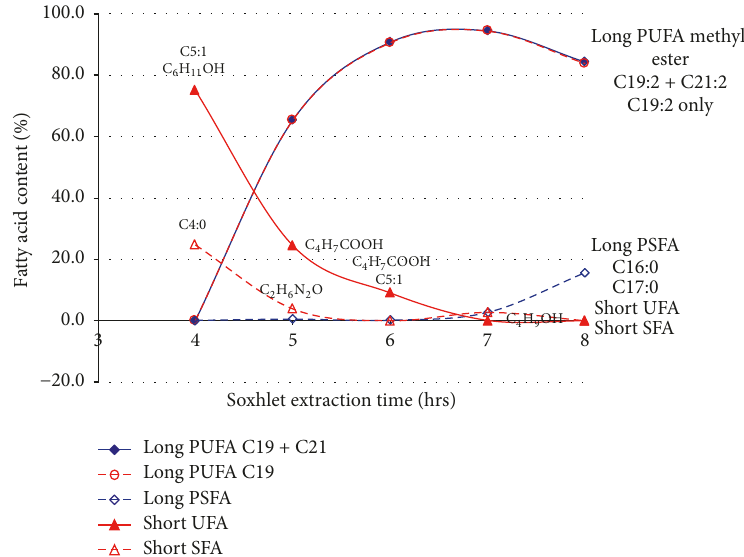
Figure 2: Fatty acids composition of FAMC over 8 h of Soxhlet extraction procedure determined by GC-MS.